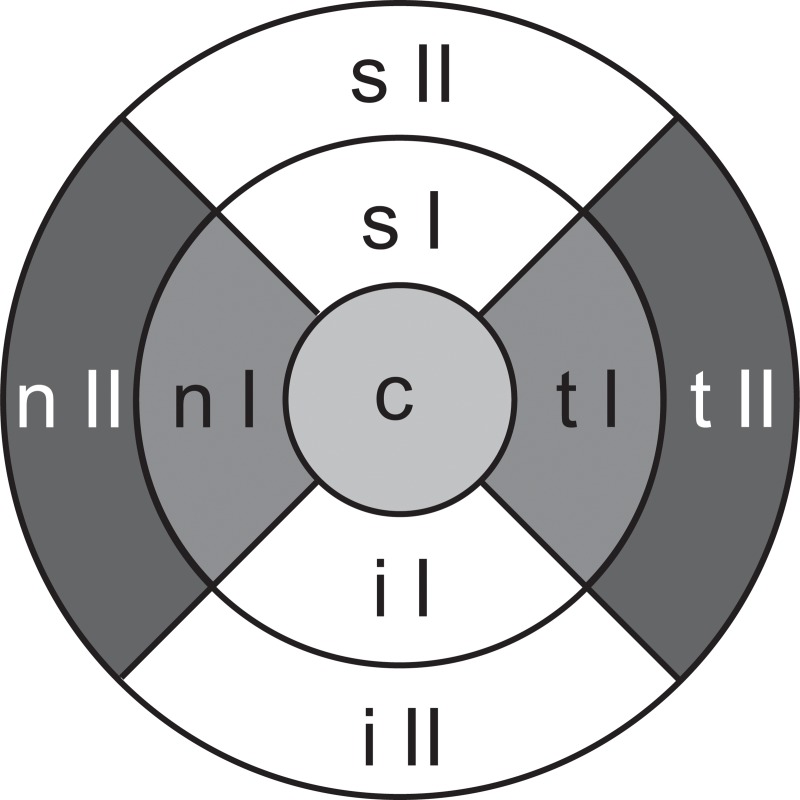
Representative thickness map highlighting the GCLT areas of particular interest along the horizontal meridian with a grey background: central (c, fovea), nasal (n) I and temporal (t) I (parafovea), nasal II and temporal II (perifovea) in a left eye. s: superior, i: inferior.